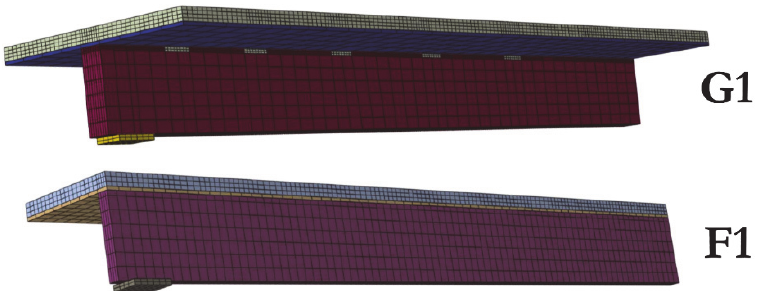
Figure 7: mesh of the simulated TCC beams with full section: G1 and F1.